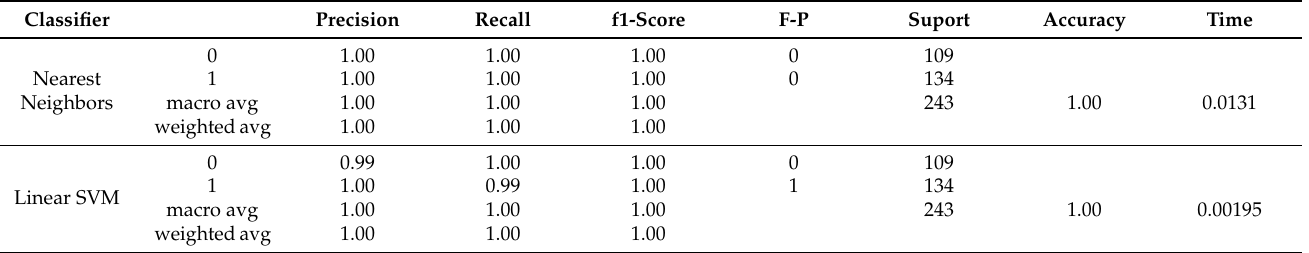
Table 4. Classification Report of different classifiers trained and tested with ExM values, values of precision, recall, F1-score, accuracy, macro avg, and weighted avg are in an average scale of (0–1), where time in